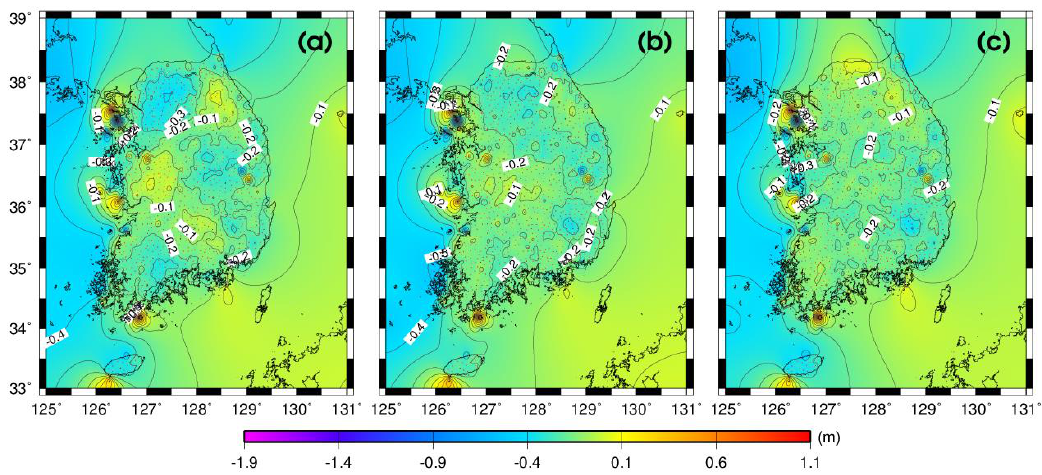
(cid:16) (cid:17) N GNSS / leveling on